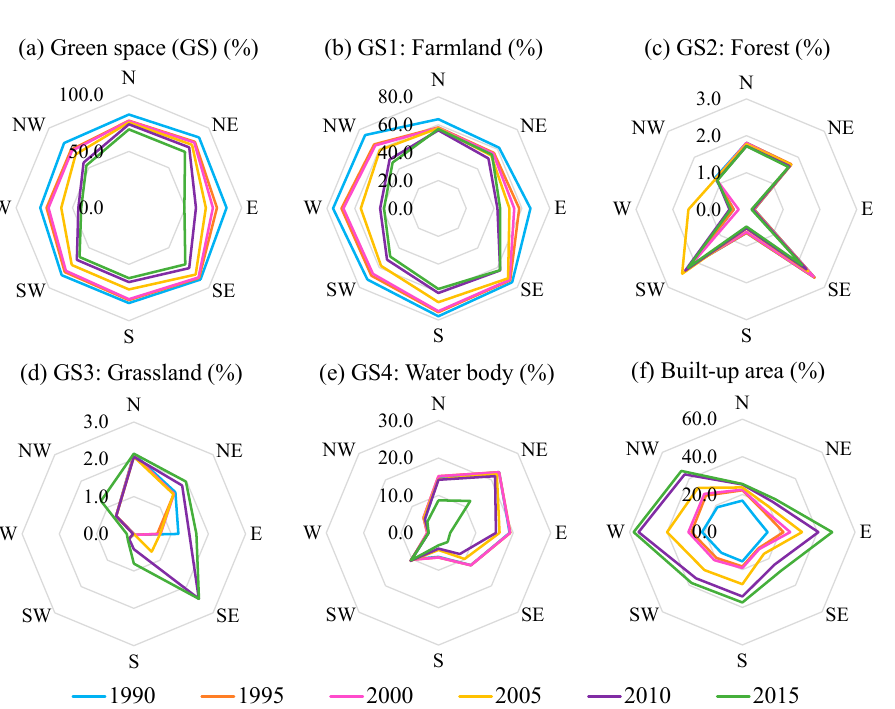
Figure 5. The spatiotemporal changes of green space in the eight directions. ( a ) The changes of overall green space in the eight directions; ( b ) The changes of farmland in the eight directions; ( c ) The changes of forest in the eight directions; ( d ) The changes of grassland in the eight directions; ( e ) The changes of waterbody in the eight directions; ( f ) The changes of built-up area in the eight directions.